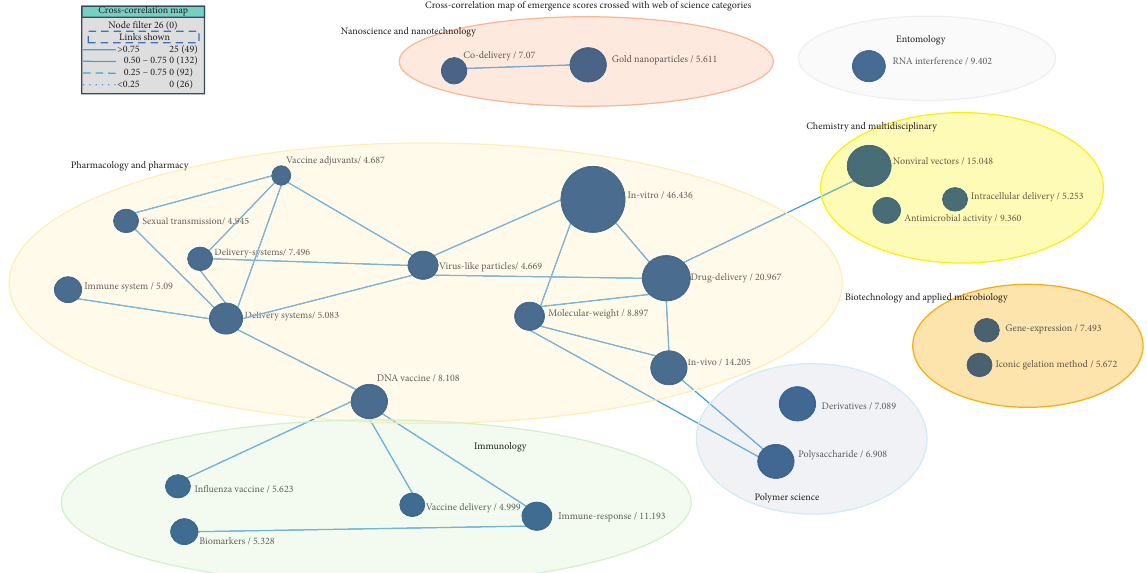
Figure 3: Cross-correlation map of emergence scores and WoS categories.